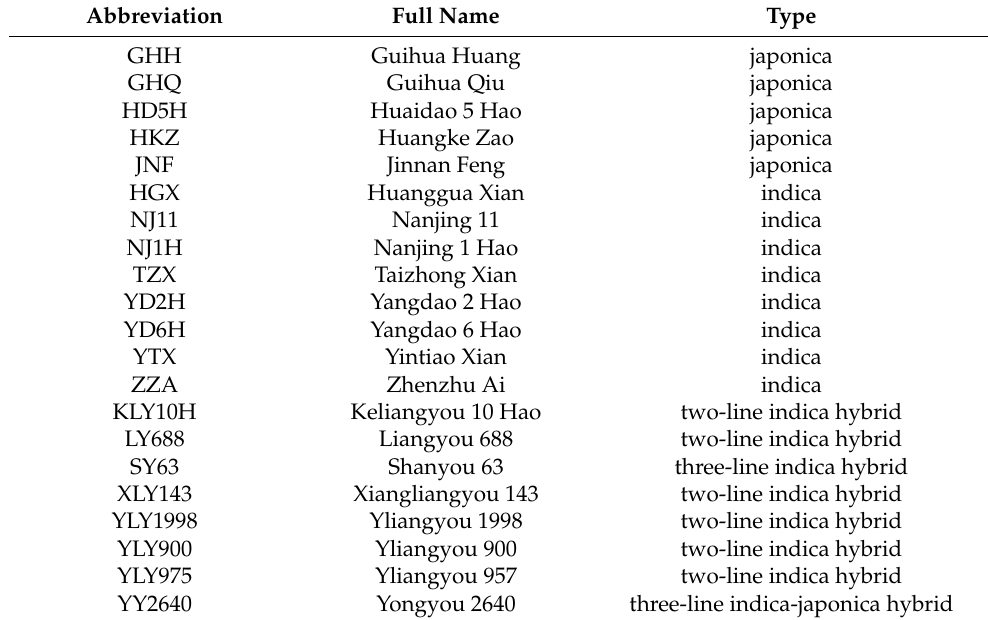
Table 1. 21 rice cultivars investigated in this